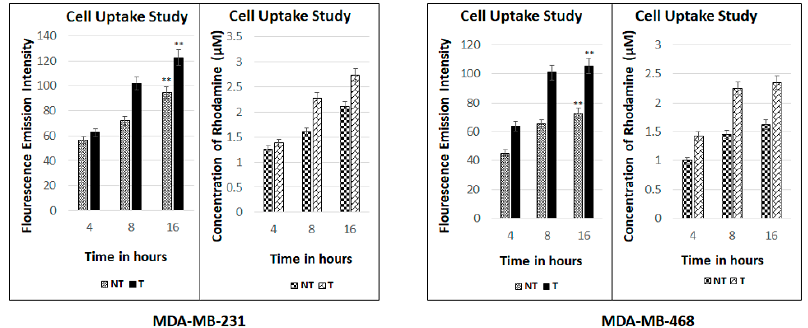
Figure 6. Fluorescence spectroscopic studies in MDA-MB-231 and MDA-MB-468 cell lines respectively for the hypoxia targeting drug delivery system HSA-PTX-ATZ. ** Statistically significant.